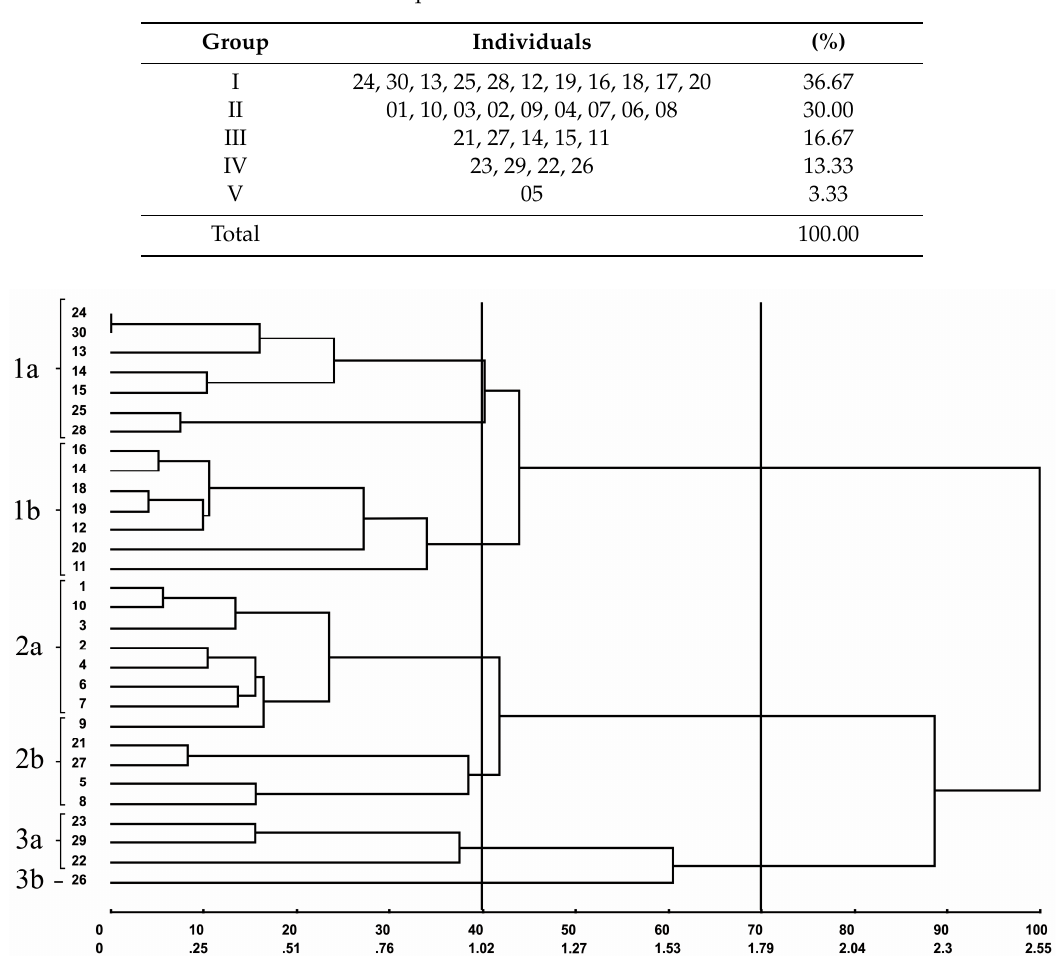
Table 1. Clustering of 30 buriti individuals according to the Tocher method, based on the standardized Euclidean distance estimated from 14 quantitative traits.